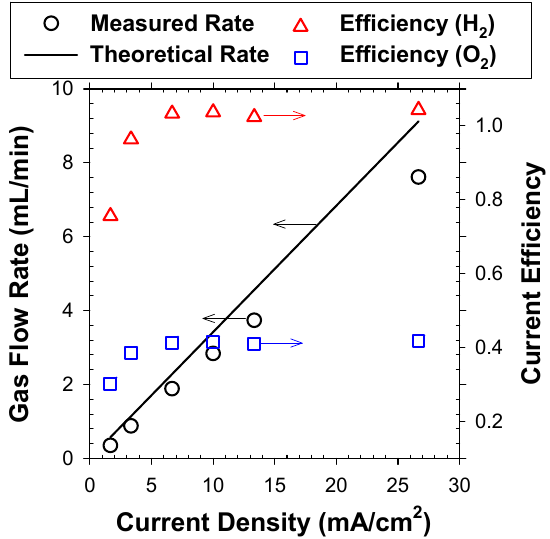
Figure 2. Measured gas flow rate of H 2 and O 2 mixture in reference with the theoretical rate. The corresponding CE values for H 2 and O 2 bubbles are shown as functions of applied j .